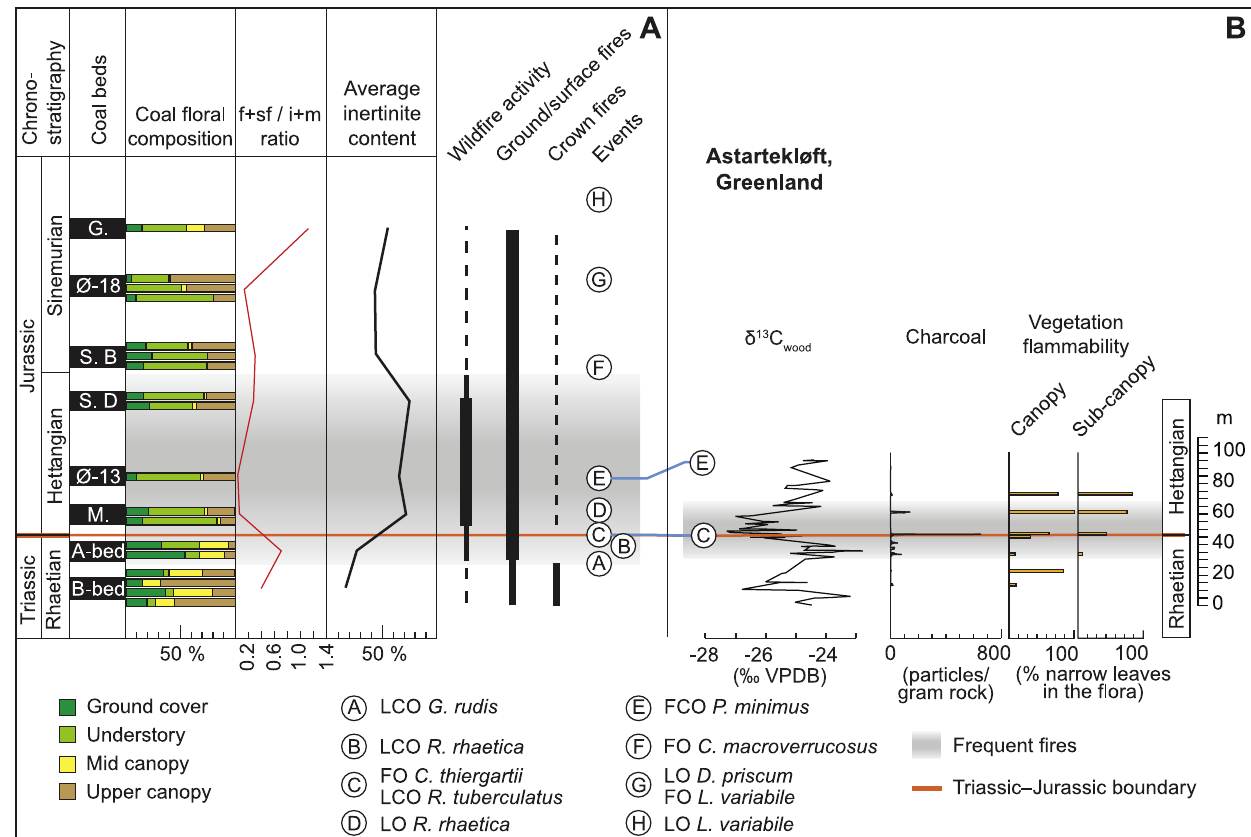
Figure 6. Comparison of the Danish Basin wildfire record with the charcoal record from Greenland. A Position of coal/coaly beds, f + sf/ i + m ratio, Average inertinite content, interpreted wildfire record and events for the Danish Basin showing shift from common crown fires to dominance of surface fires and continued high wildfire activity in mires during the entire Hettangian. B Wood Carbon-isotope record [10], charcoal record and vegetation flammability record indicating increased fire activity and vegetation adaptations across the T–J-boundary [23] for the Astartekløft T–J-boundary succession in Greenland.